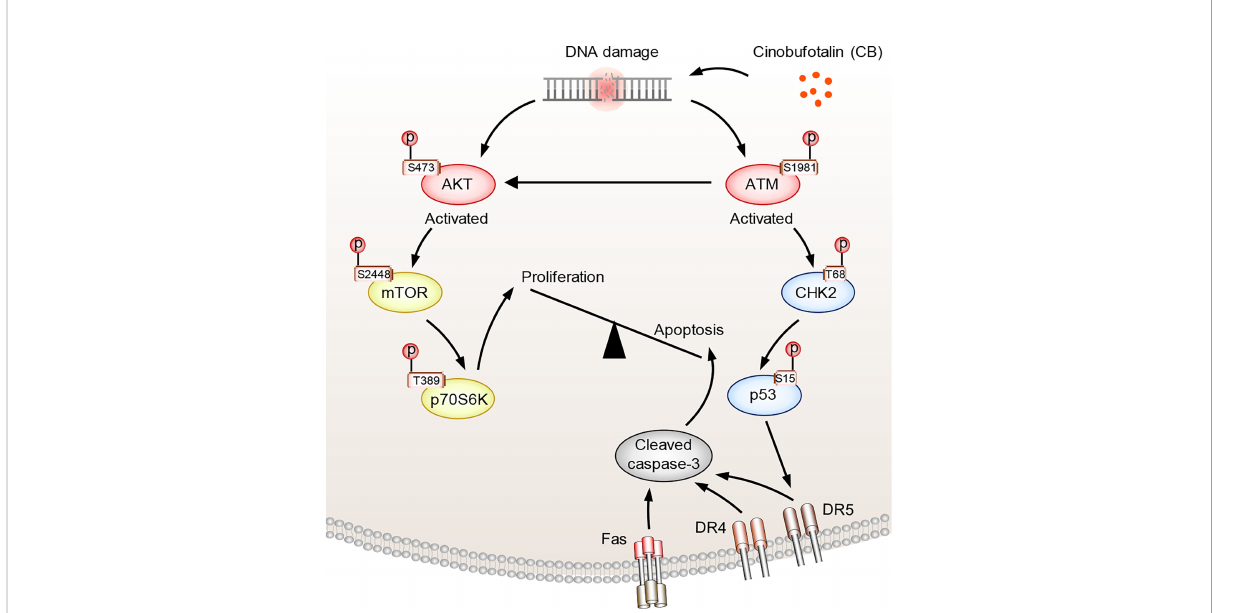
FIGURE 6 The proposed mechanism of action of CB in ICC cells. CB treatment induces DNA damage and activates ATM and AKT. Activated ATM increases p-CHK2-T68 and p-p53-S15, which promotes the expression of FAS, DR4 and DR5 and triggers cell apoptosis. Activated AKT, meanwhile, promotes cell survival by activating mTOR and its downstream signaling pathway. However, the tumor cells underwent apoptosis after CB treatment due to the predominant activation of the ATM/CHK2/p53 apoptotic